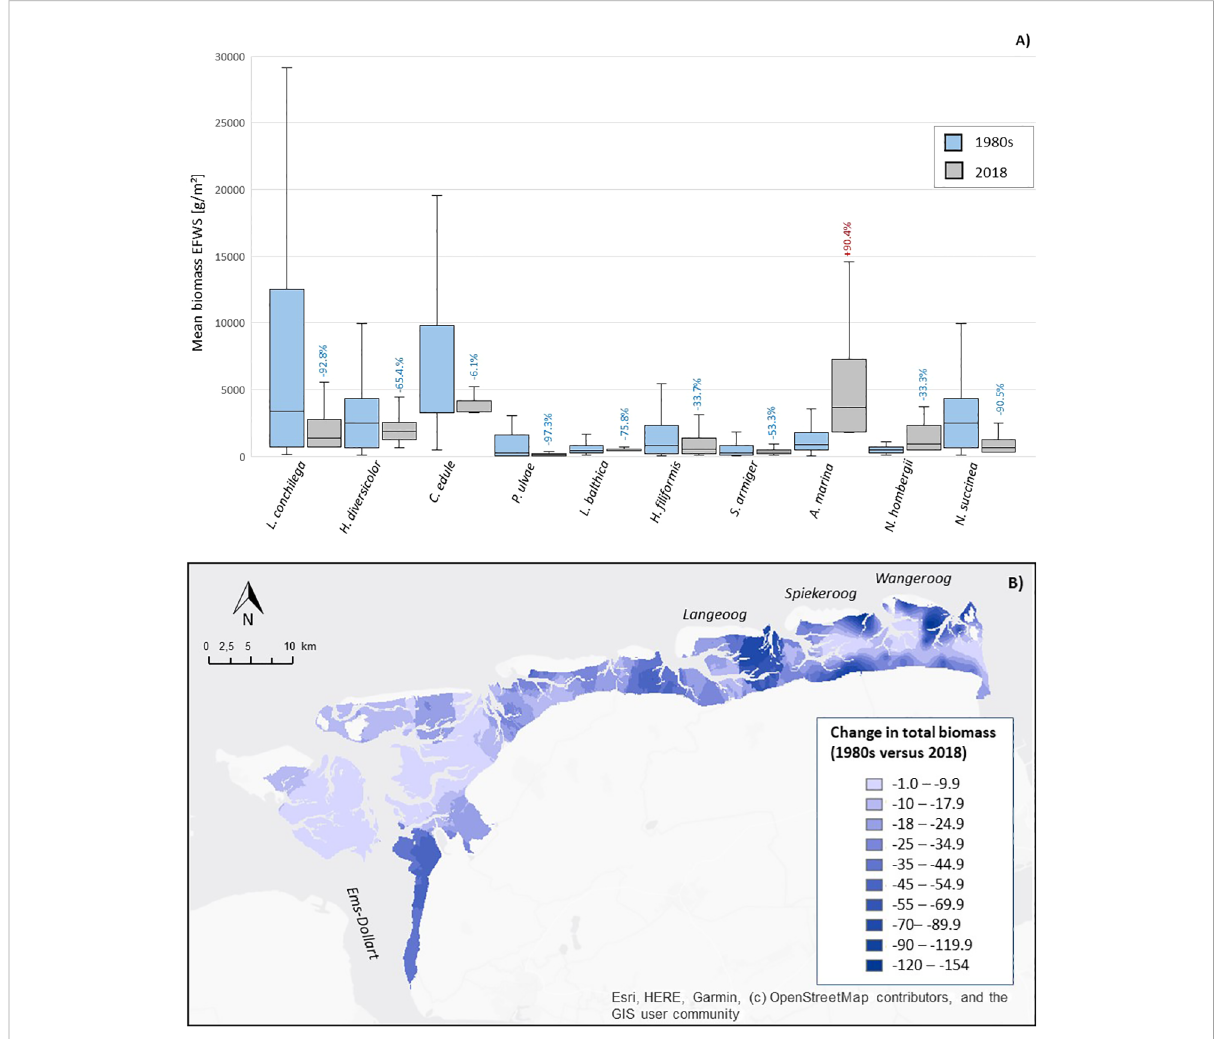
FIGURE 6 Spatio-temporal changes in the biomass of the dominant species in the East-Frisian Wadden Sea (EFWS); (A) boxplot showing the changes in the mean biomass [g/m²] between the 1980s and 2018, with % total biomass decrease (1980 versus 2018, blue color) and % total biomass increase (1980 versus 2018, red color), the two biomass-dominant species M. edulis and S. plana were not displayed in this fi gure to enhance data visibility of the other species; (B) map of the total biomass changes [g] in the East-Frisian Wadden Sea (1980s versus